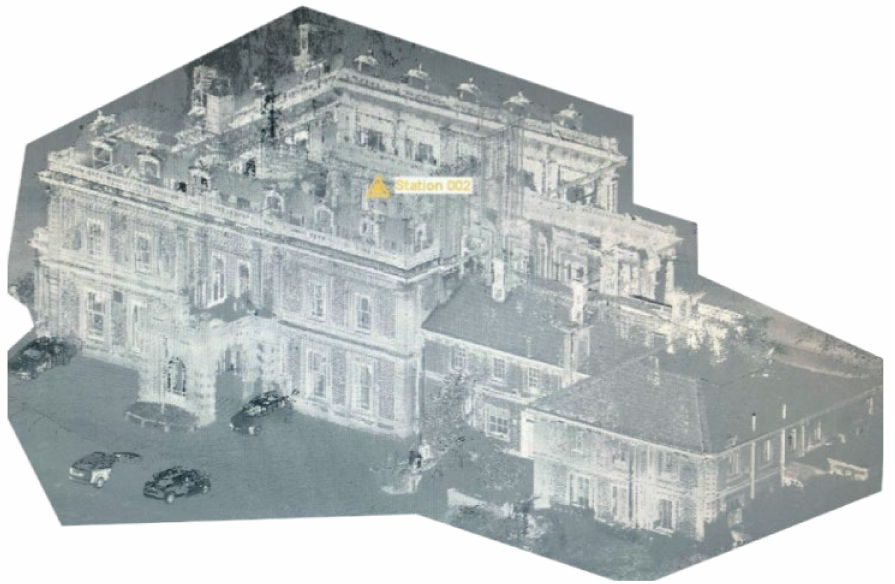
Figure 10. Headington Hill Building exterior cloud